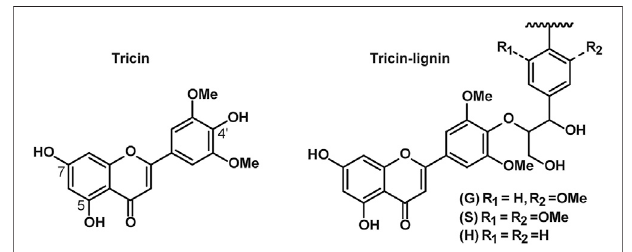
FIGURE1| Chemicalstructuresoftricinandlinkagesbetweentricinand other lignin units.